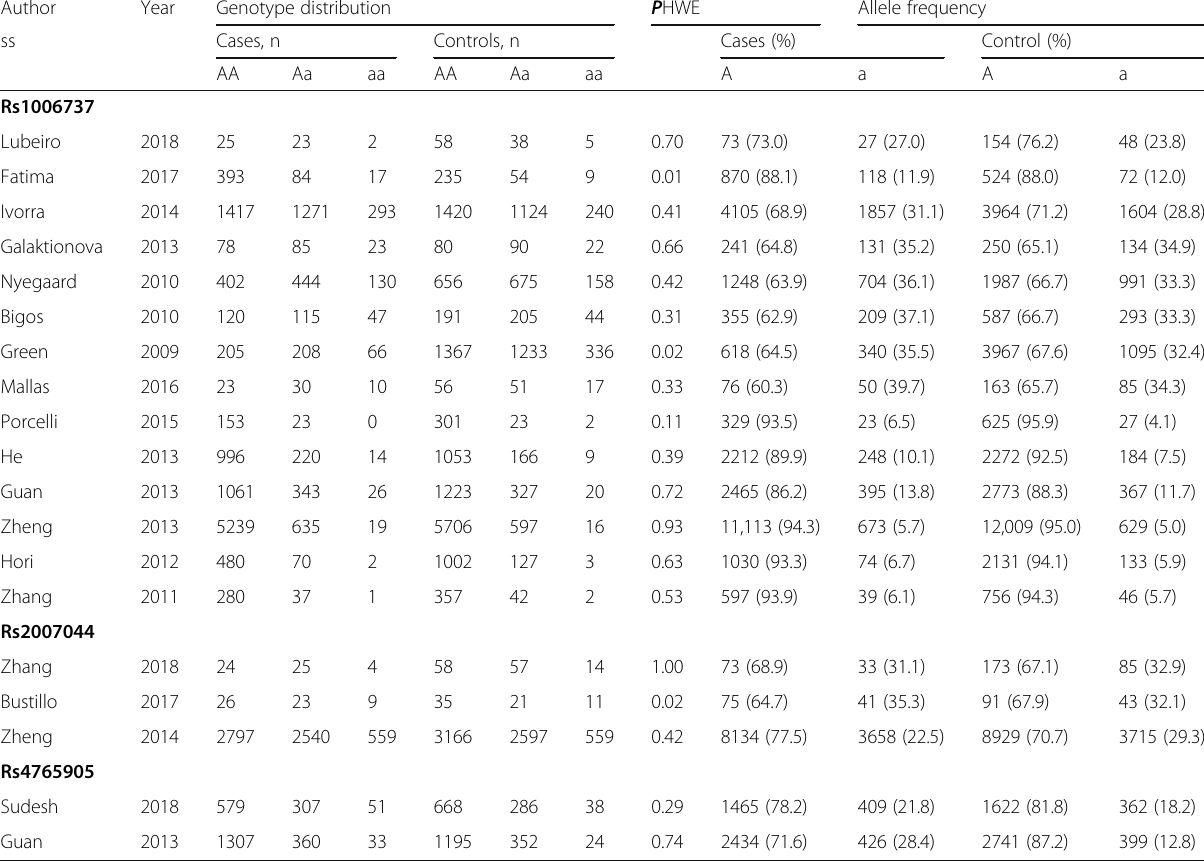
Table 2 The distributions of the allele frequency and genotype in the included